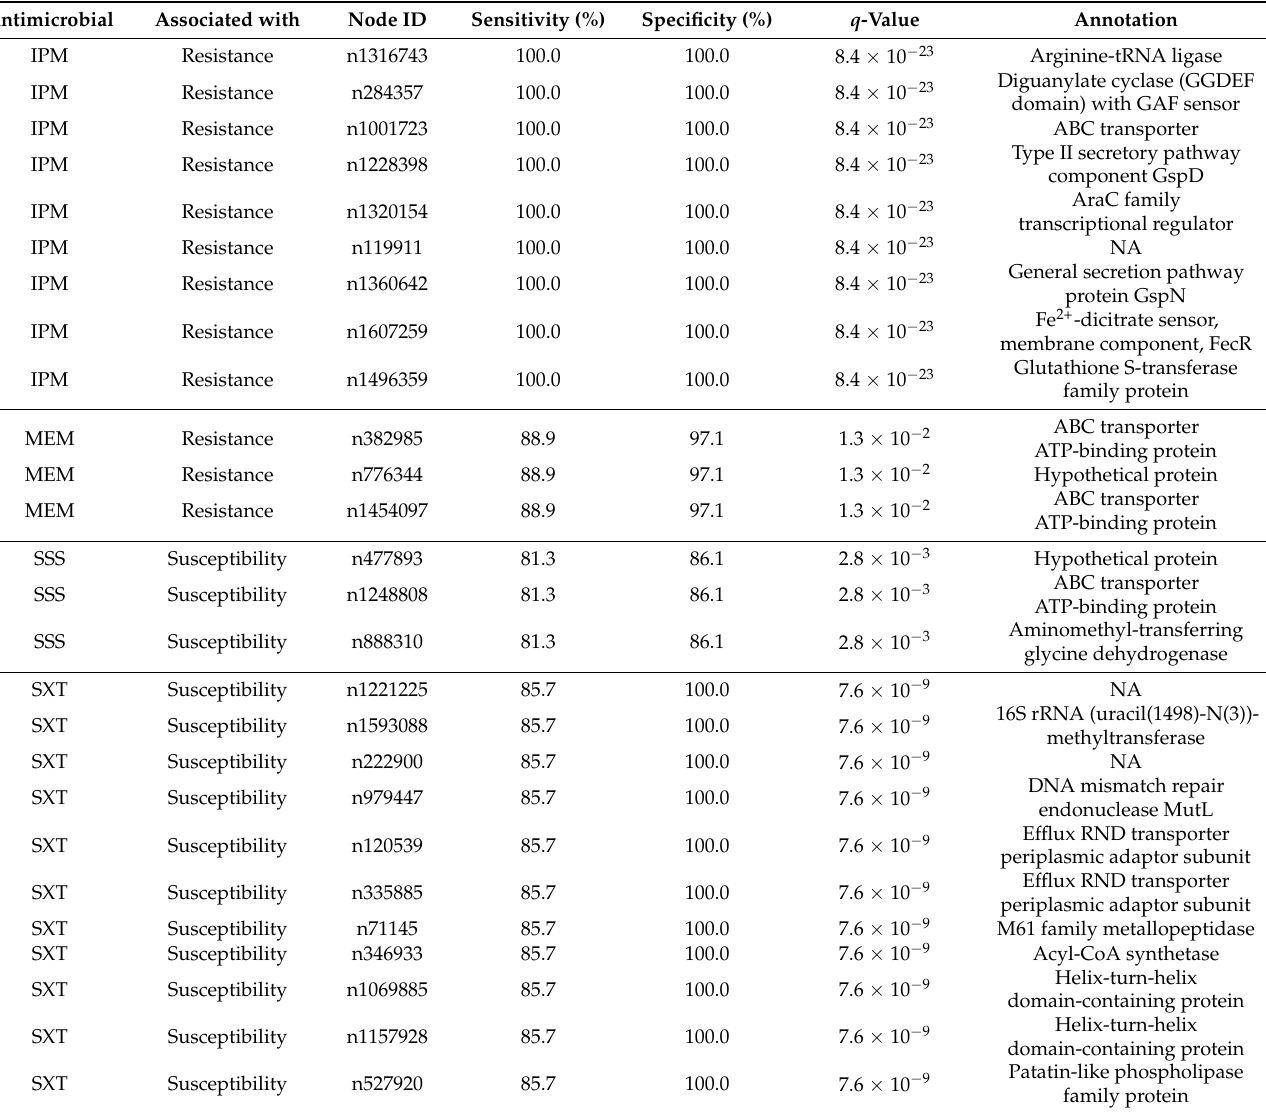
Table 1. Genetic loci significantly associated with antimicrobial resistance. The most significant results of association analysis are reported. IPM = imipenem, SXT = trimethoprim–sulfamethoxazole, SSS = sulfonamides (sulphadiazine, sulphathiazole), MEM = meropenem, q -value = p -value adjusted for the False Discovery